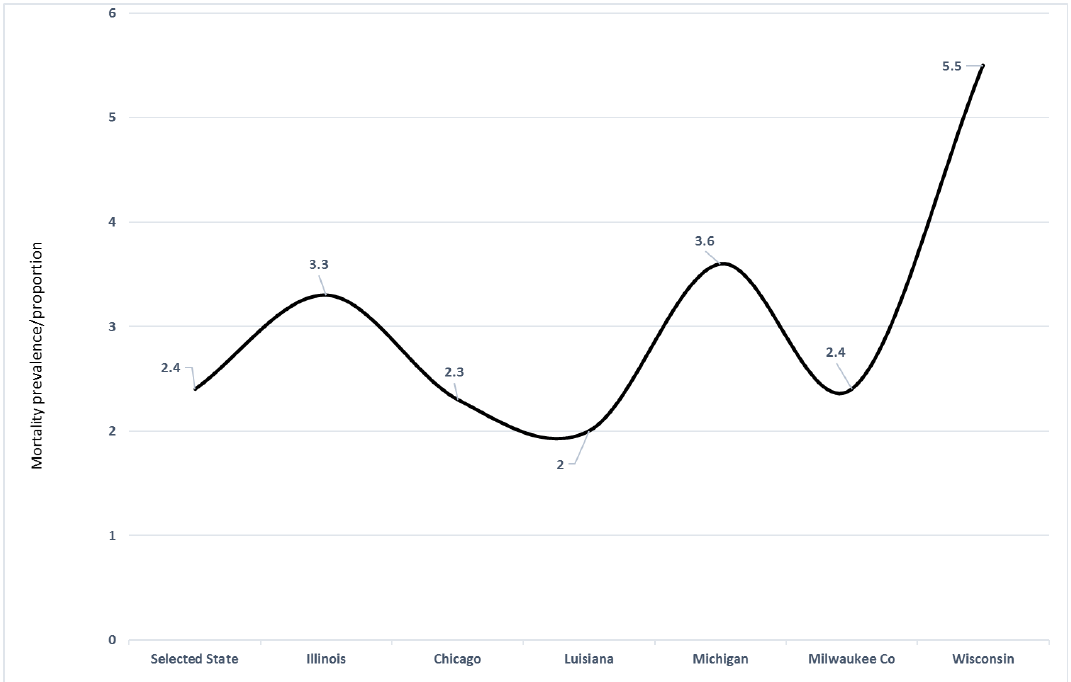
Figure 3. Disproportionate magnitude of COVID-19 mortality on Blacks/AA in selective states and county, 9 – 13th April 2020. Notes: The point estimates on the line indicates the burden of COVID-19 mortality in the Black/AA communities in these geographic locales. As per mid-April 2020, the COVID-19 disproportionate burden of dying was outstanding in Wisconsin, Michigan and Illinois (mid-western states).